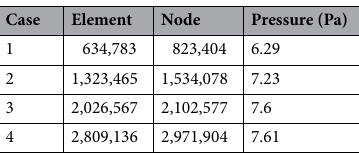
Table 4. Number of elements and nodes in four different levels of mesh independency analysis.